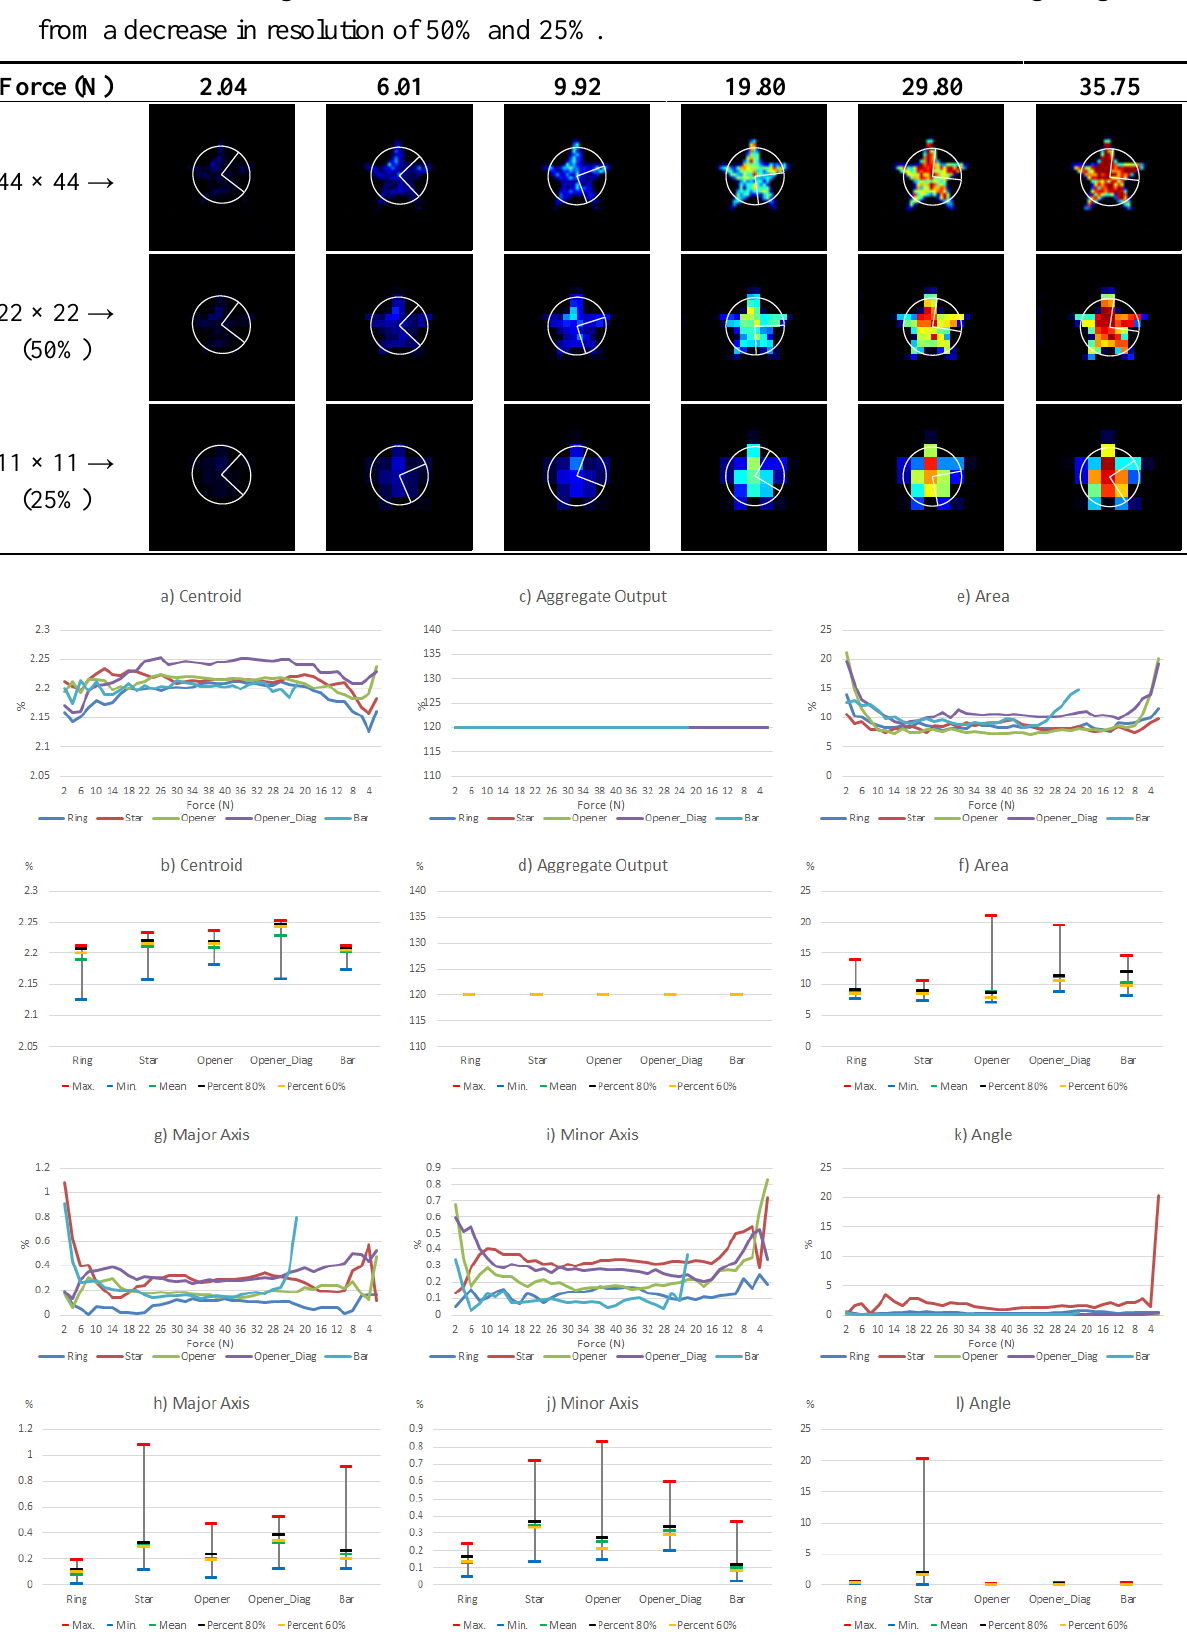
Figure 12. Variations of the system level parameters caused by a 50% decrease of the resolution in tactile images obtained with the commercial